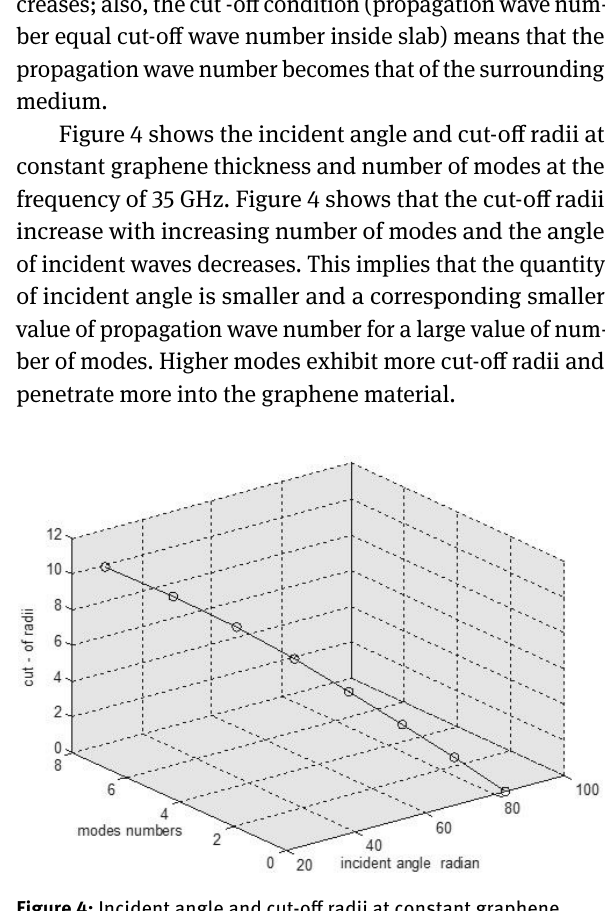
Figure 4: Incident angle and cut-off radii at constant graphene thickness & number of